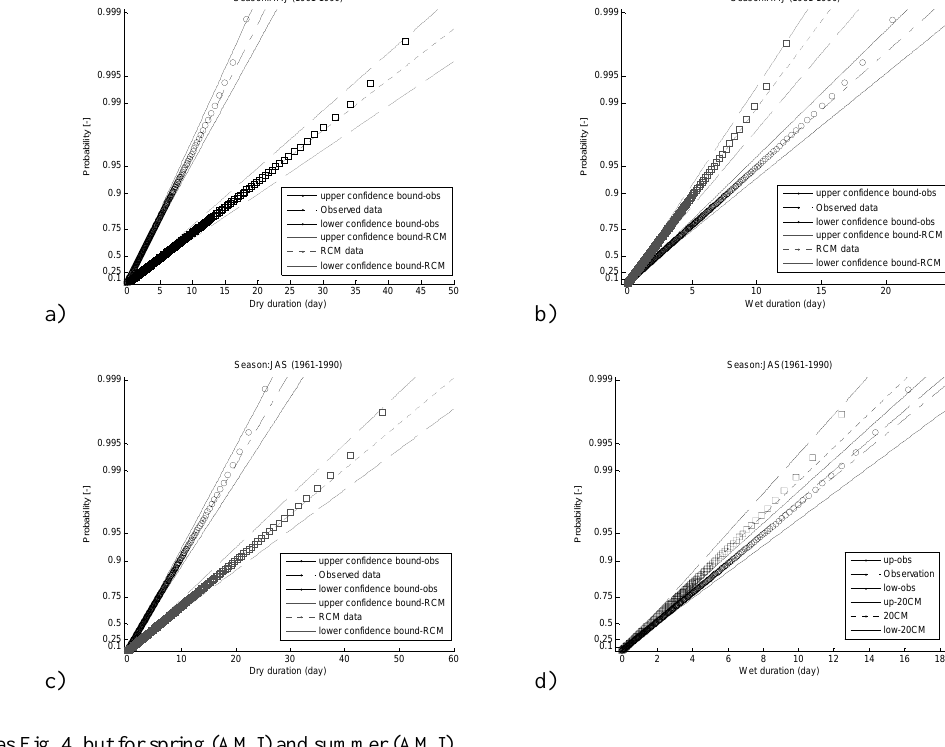
upper confidence bound-obs Observed data lower confidence bound-obs upper confidence bound-RCM RCM data lower confidence bound-RCM